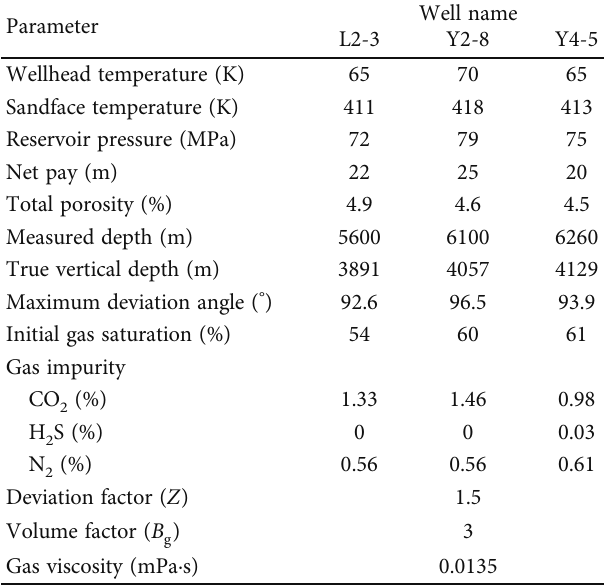
Table 6: Calculation parameters of modern PDA